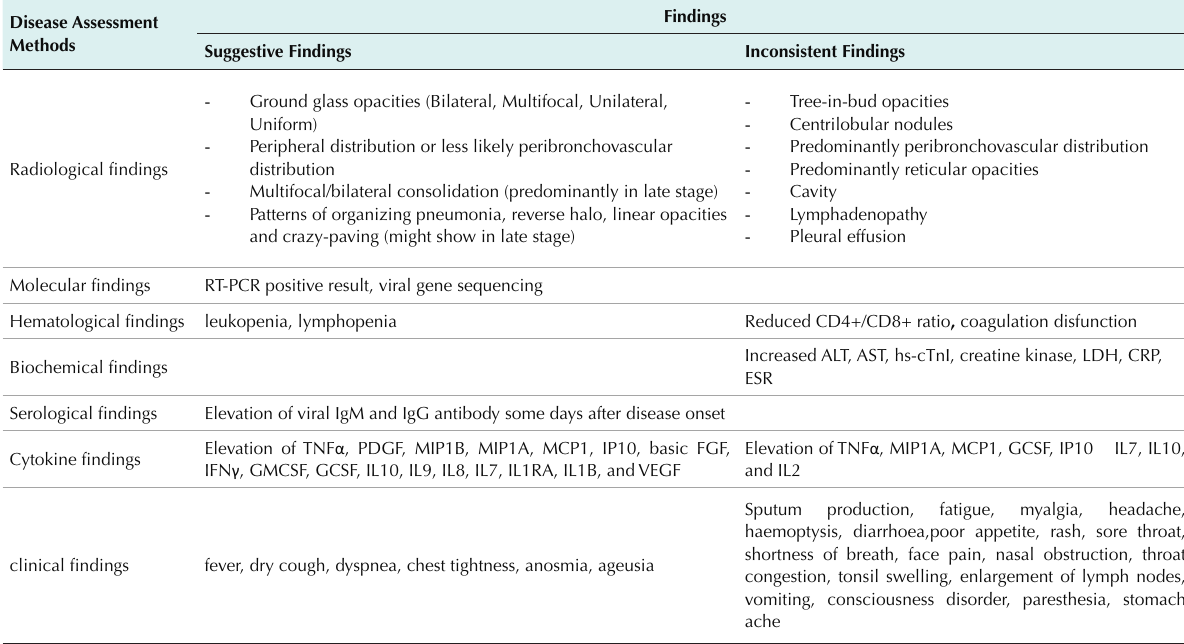
Table 1. Clinical Symtoms, Laboratory and Radiological Findings of Patients Infected With COVID-19 (2, 5, 6, 8, 18, 19, 22, 25, 27, 28, 30-33) Disease Assessment